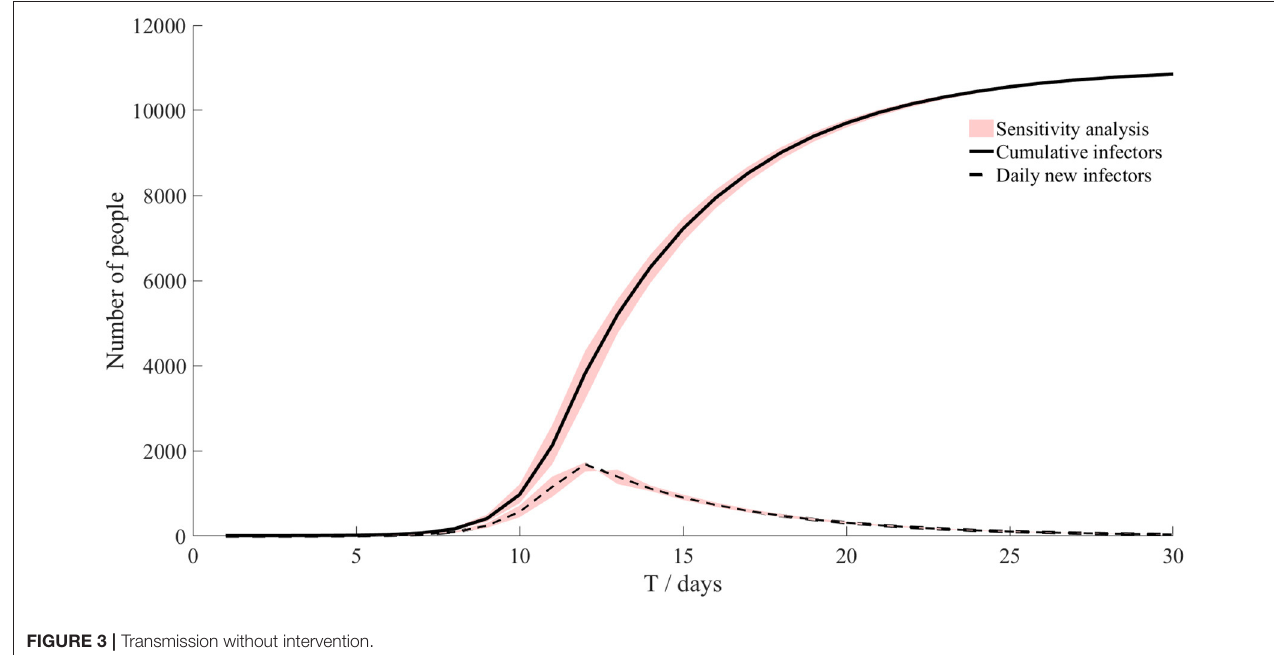
FIGURE 3 | Transmission without intervention.